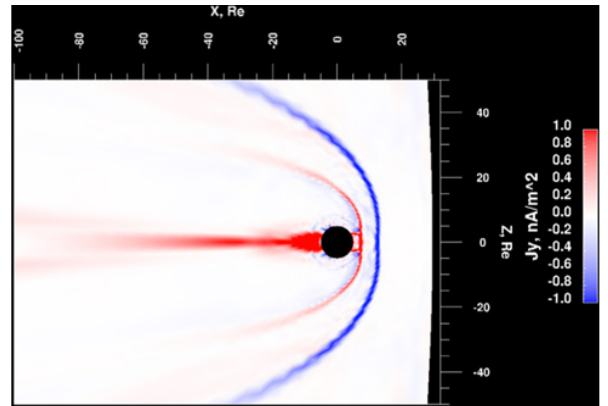
Fig. 3. Distribution of J y in the meridional plane as determined from the LFM magnetosphere simulation under solar wind con- ditions that produce saturation with purely southward IMF ( V = 400kms − 1 , n = 5cm − 3 , B z =− 20nT).